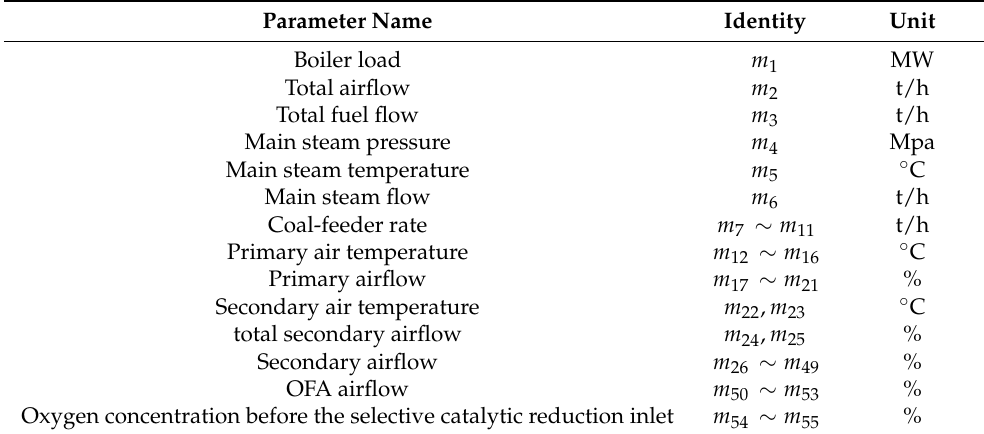
Table 1. Variables used in the